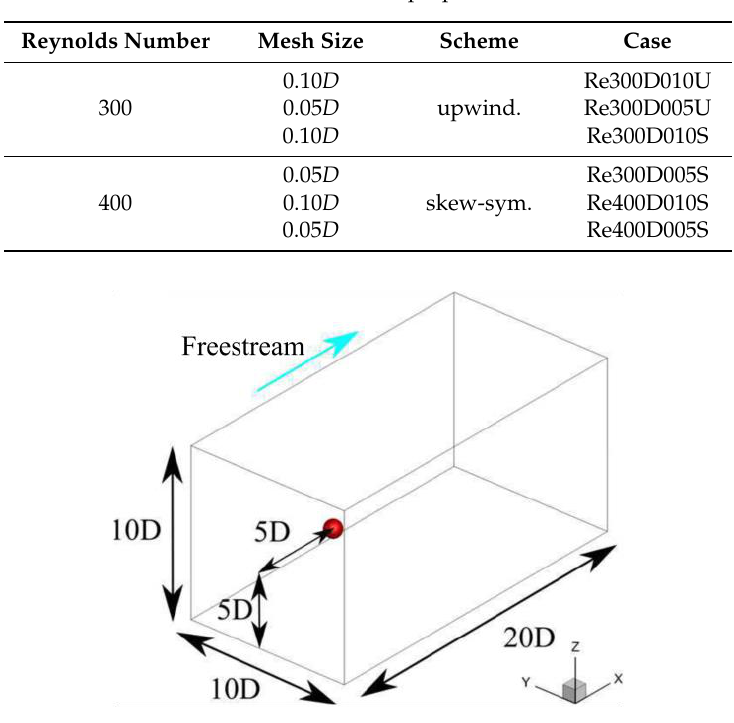
Table 1. Test cases in the proposed model.